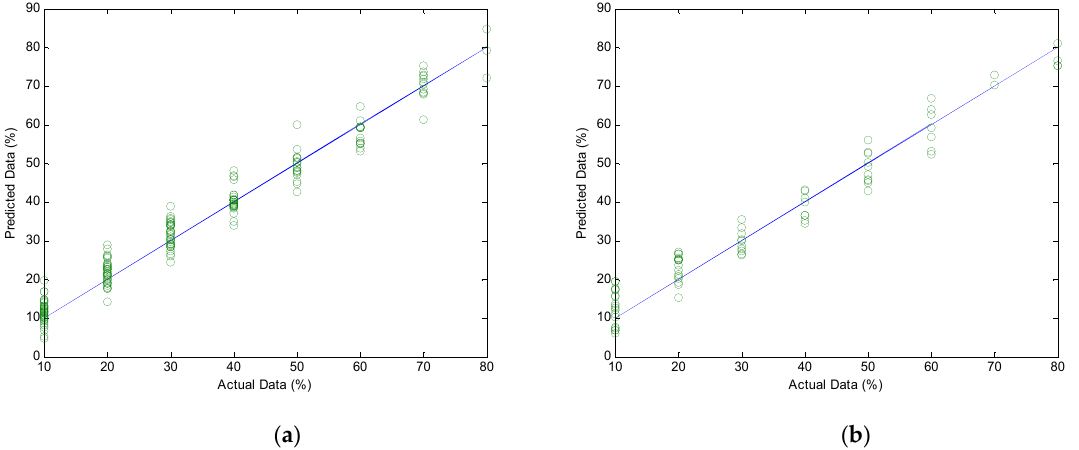
Figure 11. Regression diagrams of first model results (gas volume fraction) for ( a ) train data ( b ) test data.